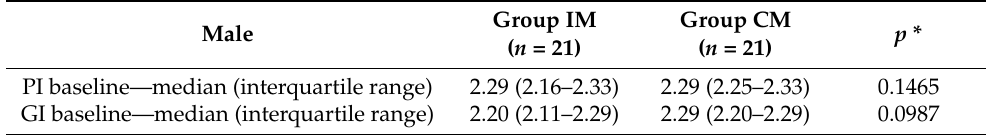
Table 4. Median (interquartile range) of PI and GI at baseline in male patients.